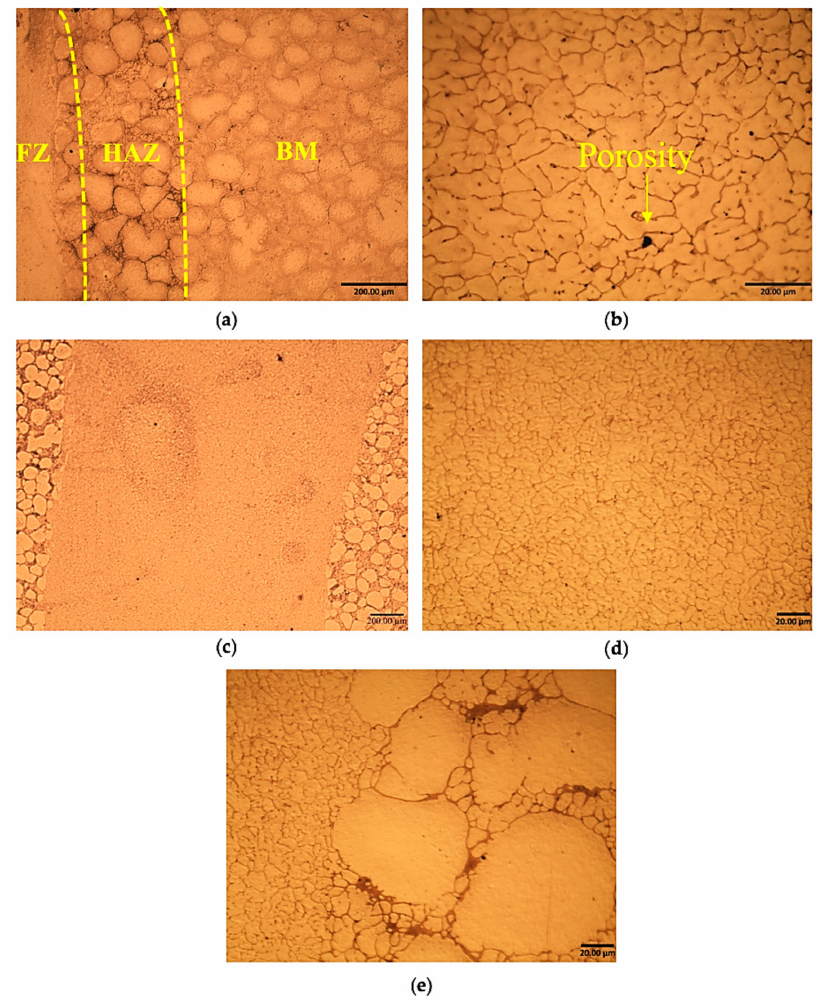
Figure 4. ( a ) Optical micrographs of Al 7075 EB welded plates, ( b – d ) show details of the Fusion Zone (FZ) and ( e ) detail of the plate weld